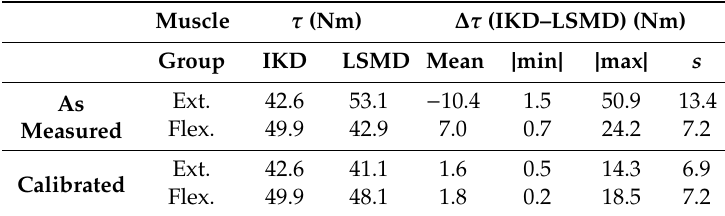
Table 7. E ff ect of calibration on session II LSMD torque data. Muscle